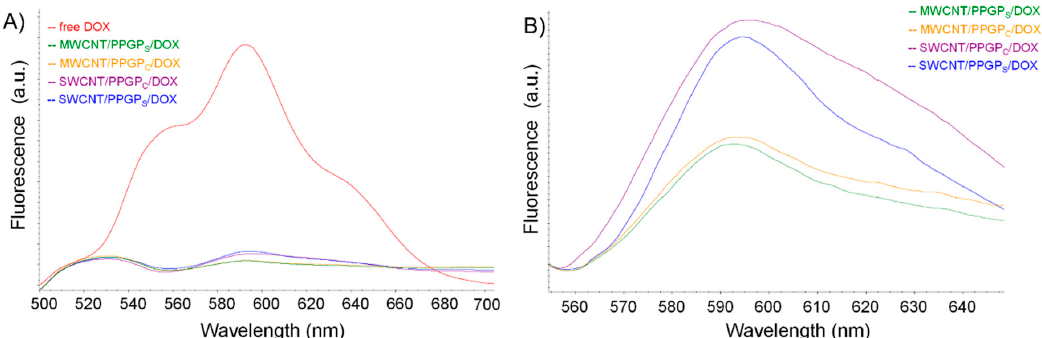
Figure 10. Normalized fluorescence intensities spectra of: (Panel A ) DOX and CNT / PPGP / DOX nano complexes; (Panel B ) CNT / PPGP / DOX nano complexes, zoom in the region between 560 to 640 nm. Irradiation at 480 nm.